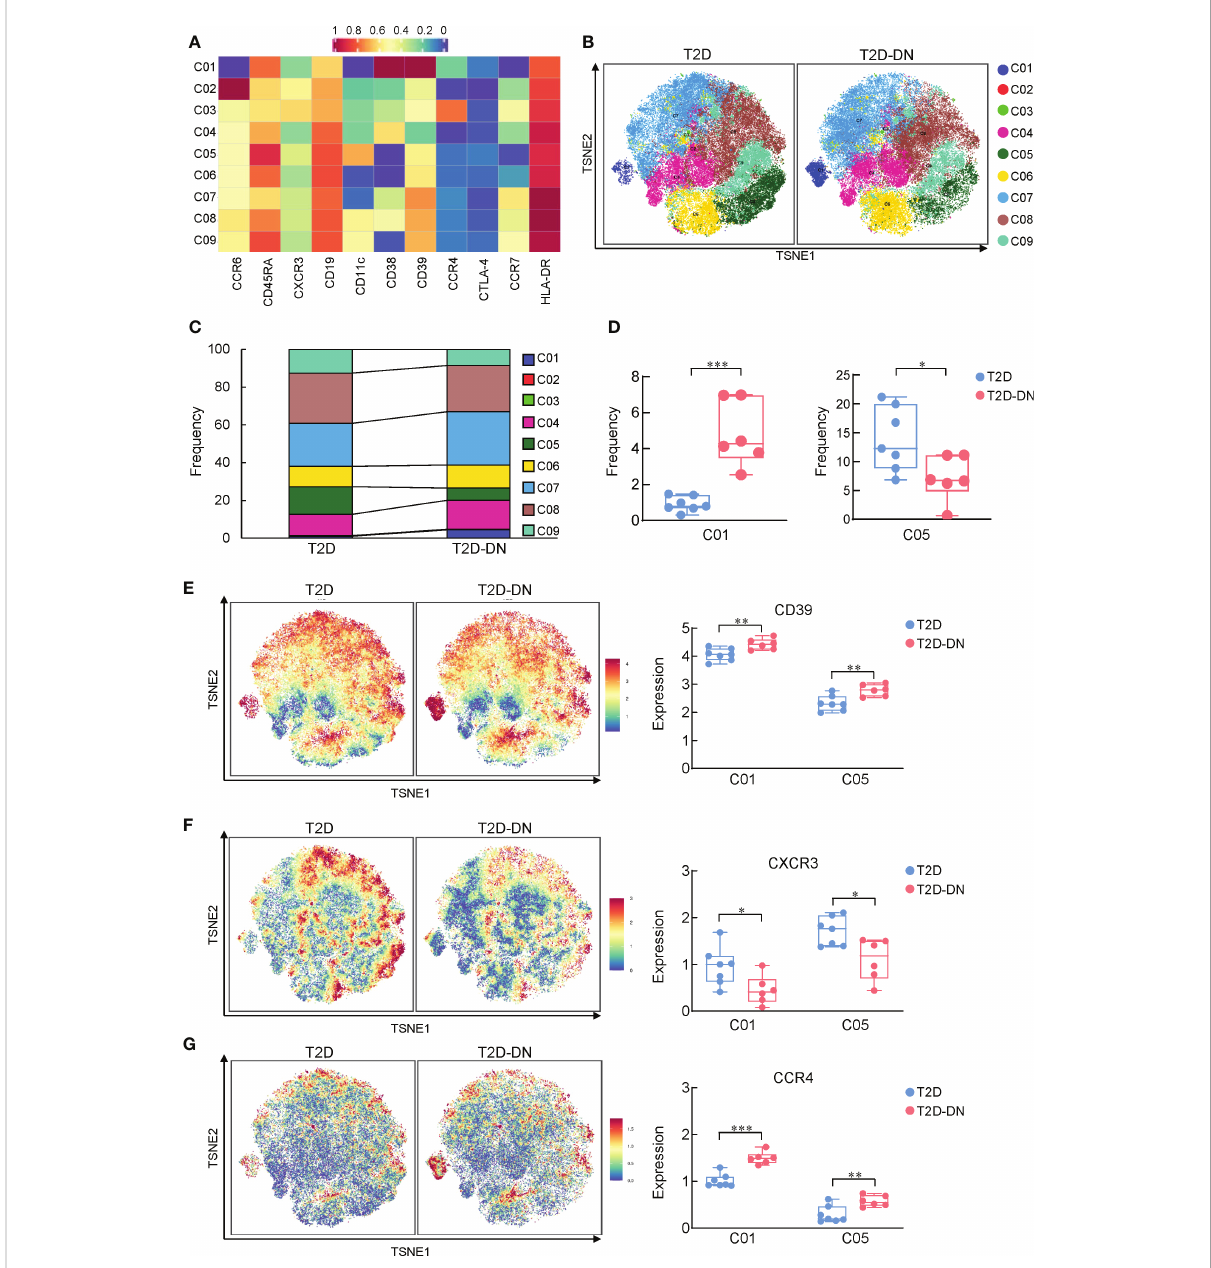
FIGURE 3 Depiction of features of B cell subsets between T2D-DN and T2D patients. (A) Heatmap exhibiting the expressions of immune cell markers in the B cell subsets. (B) Island maps display the measurable B cell subsets distribution. (C) Statistical frequency differences of B cell subsets between T2D-DN and T2D patients. (D) Signi fi cantly changed B cell subsets between T2D-DN and T2D patients. (E) CD39, (F) CXCR3 and (G) CCR4 in the speci fi c B cell subsets between T2D-DN and T2 patients. Data are expressed as means ± SEM, n = 6 in T2D-DN group and n = 7 in T2D group., * P < 0.05, ** P < 0.01, *** P < 0.001 vs. T2D